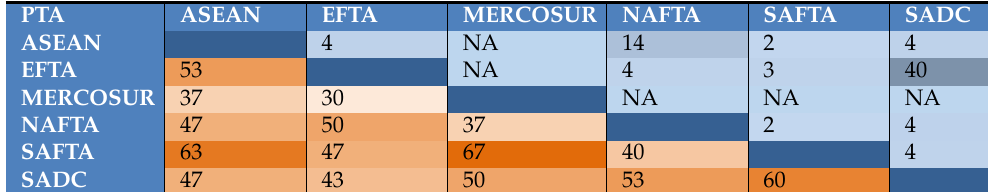
Table 1. How different are RWRs across the main PTA families: Textual overlap and regulatory